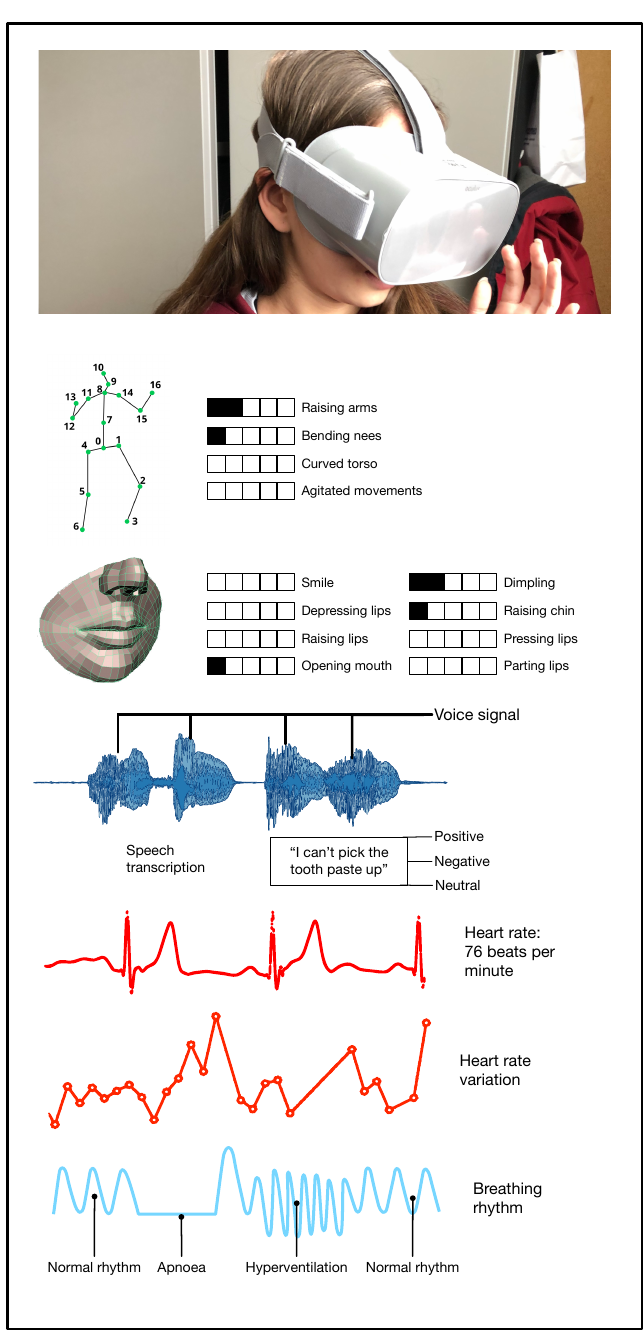
Figure 1. Biometric and physiological data sources for dynamic game